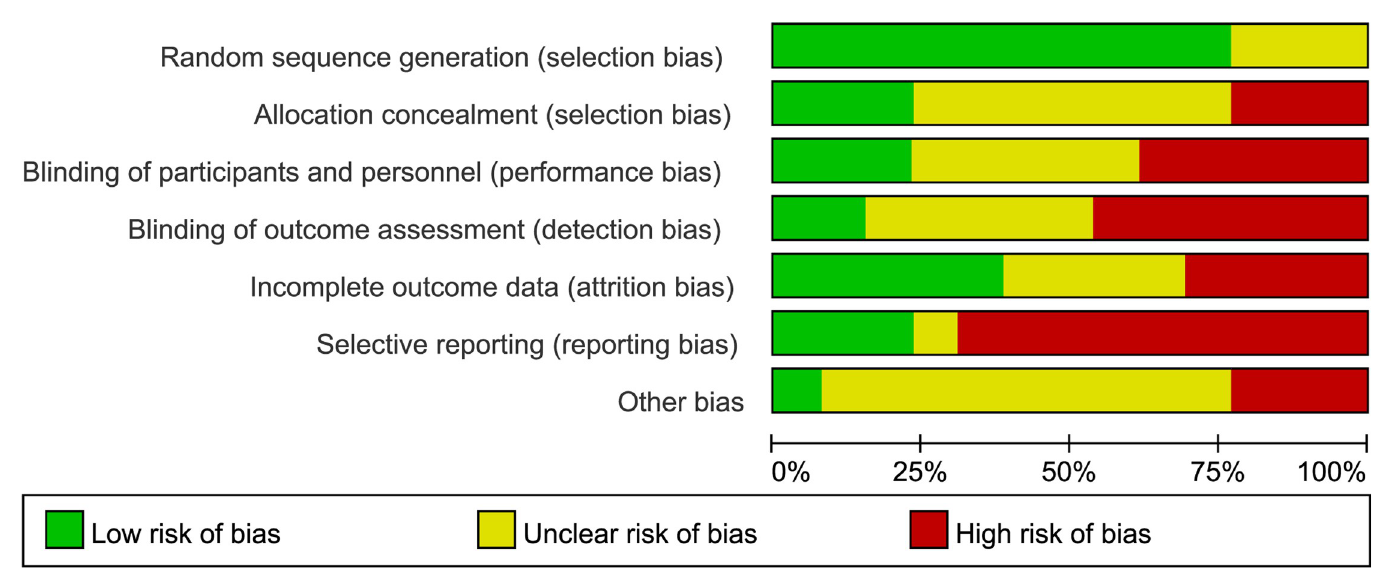
Fig 4. Risk of bias graph.